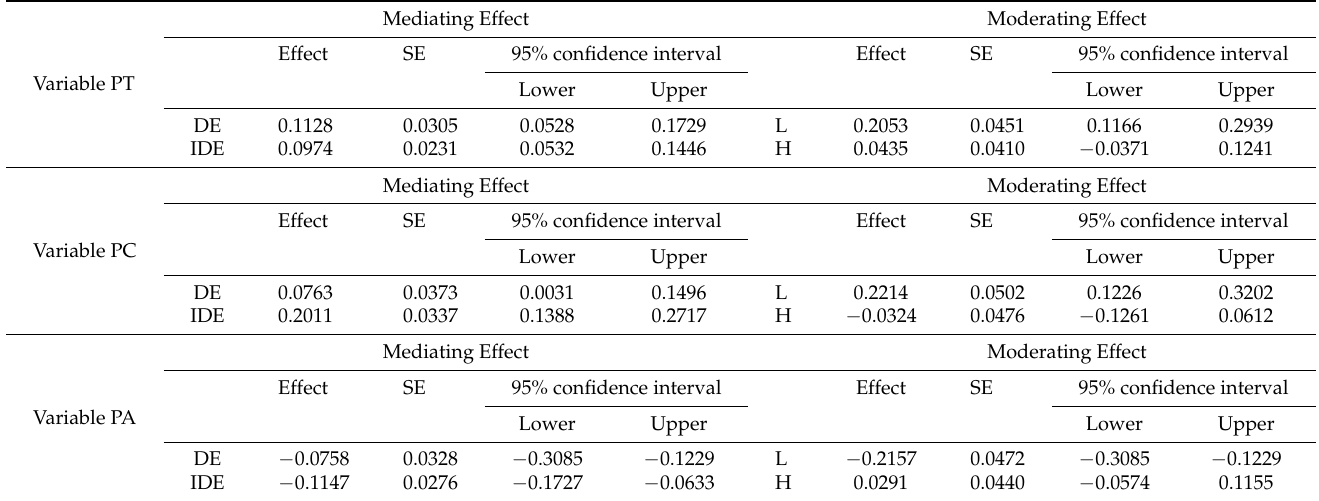
Table 3. Mediating Effect and Moderating Effect (N =